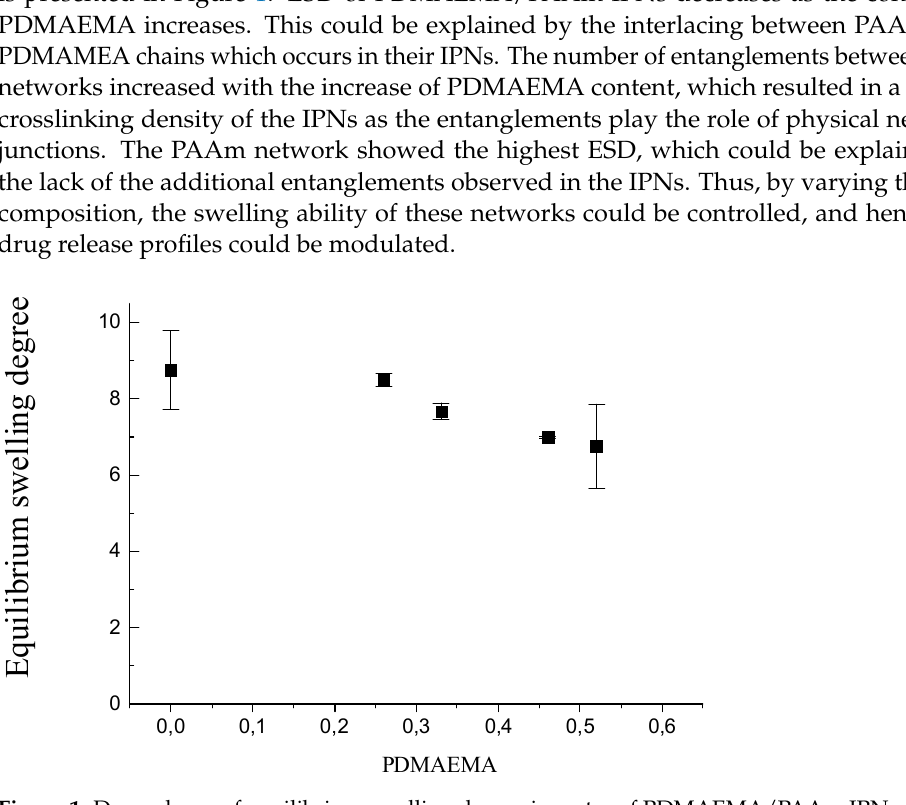
Figure 1. Dependence of equilibrium swelling degree in water of PDMAEMA/PAAm IPNs on their composition, φ PDMAEMA .